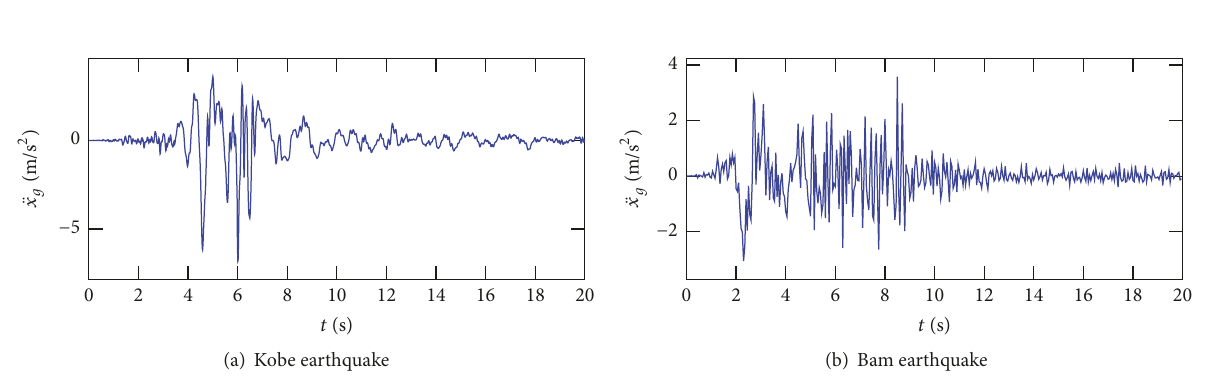
Figure 12: Acceleration time history of the Kobe and the Bam earthquake excitation.